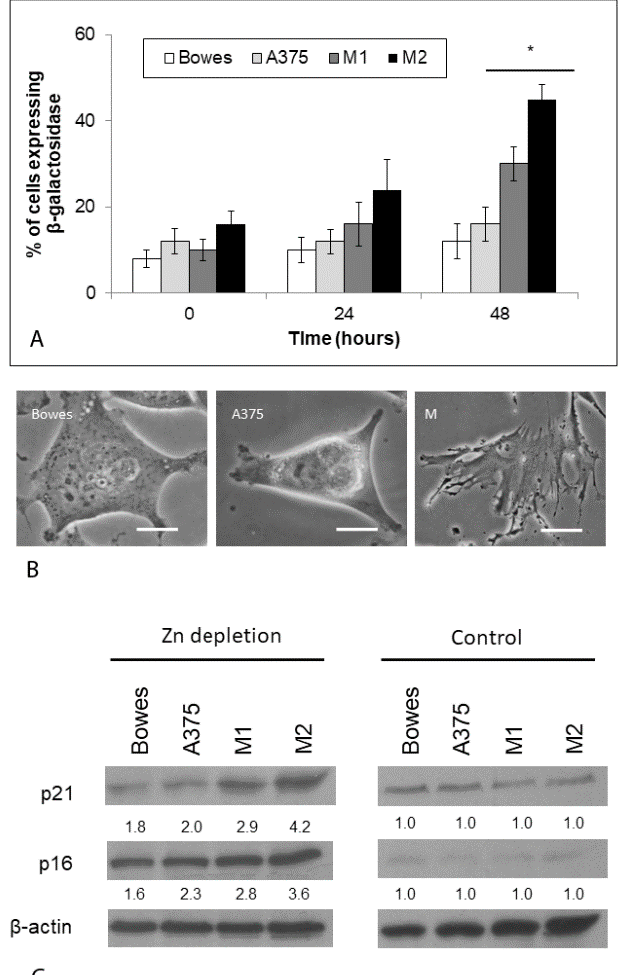
Figure 11. Premature senescence in free zinc depleted human melanoma cells Bowes and A375 and melanoma explant cultures M1 (low free zinc) and M2 (high free zinc) before and after exposure to standard cultivation medium supplemented with 100 µ M zinc sulfate during 48 h. ( A ) Beta galactosidase positivity was determined microscopically. Results represent means ± SD of at least three independent experiments. p < 0.05 * Significantly higher compared to the beginning of treatment with one-way-Anova test and Dunnett’s post test for multiple comparisons. ( B ) Phase contrast mi- croscopy, 600×, scale bar 2 µm. ( C ) Expression of p21 and p16 proteins was determined by im- munoblotting. Control—cells cultivated under standard, zinc adequate conditions (48 h). Zn-deple- tion—cells with original free zinc depleted and then cultivated for 48 h with standard growth me- dium supplemented with 100 µM zinc sulfate. The loading was normalized to β -actin and quantita-